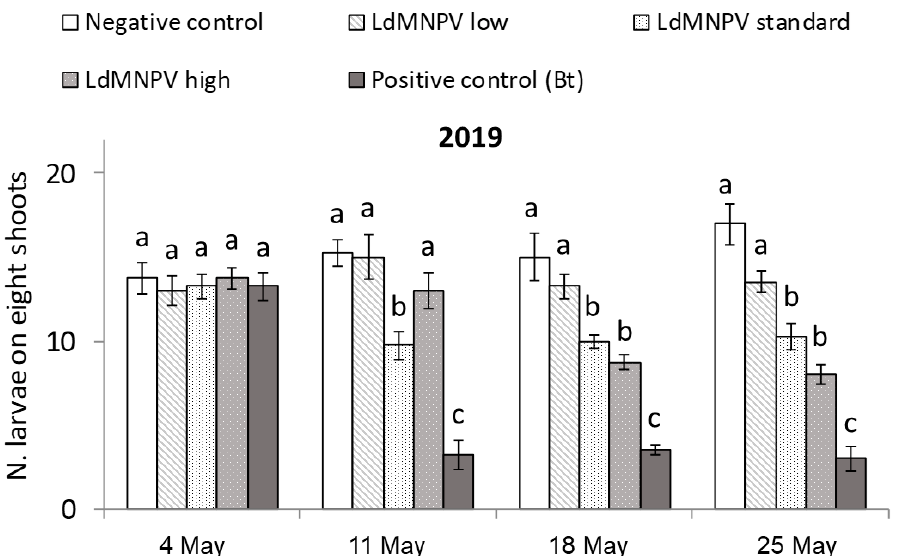
Figure 4. Larval density (mean ± SE) assessed by sampling 8 shoots/plot in the dose–response trial with LdMNPV applications from the ground in 2019. Different letters (a, b, c) above bars indicate significant differences among means within each sampling date (ANOVA Mixed Proc., LSMEANS, p < 0.05).